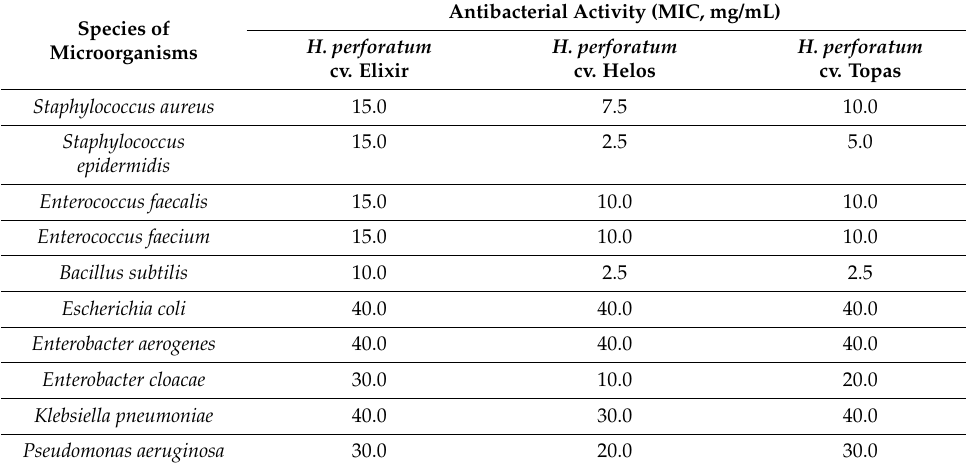
Table 3. Antibacterial activity (MIC—minimum inhibitory concentration) of the methanolic extracts obtained from the biomass of in vitro agitated cultures of the H. perforatum cultivars Helos, Elixir, and Topas against Gram-positive and Gram-negative bacteria (MS, 0.1 mg/L BAP and 0.1 mg/L NAA, 5 weeks). Antibacterial Activity (MIC, mg/mL) Species of H. perforatum Microorganisms cv.